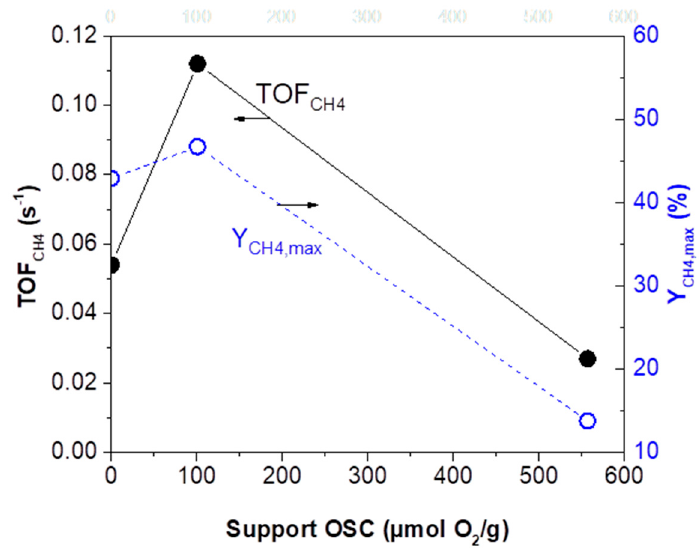
Figure 4. Dependence of methane turnover frequency ( TOF CH4 ) at T = 280 °C and maximum methane yield ( Y CH4,max ) on support oxygen storage capacity. Experimental conditions as in Figures 2 and 4.